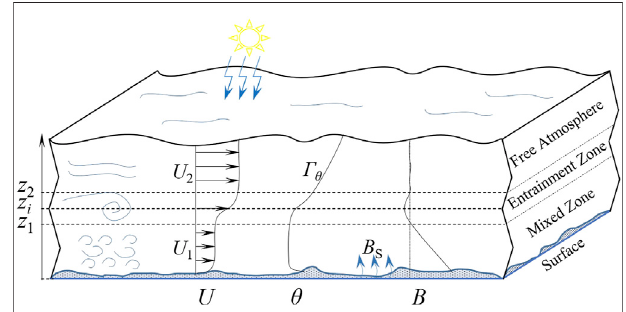
FIGURE 1 | Schematic diagram of the sheared CBL and the vertical distributionofthehorizontal velocity U ,potentialtemperature θ ,andbuoyancy fl ux B. B fl ux; Γ θ isthe potentialtemperature gradient S is thesurface buoyancy ofthe freeatmosphere; z i , z 1 ,and z 2 denotethe height, upper, and lower limits oftheentrainmentzone, respectively; z S referstothelevel ofthesurface; and U 1 and U 2 are the horizontal mean